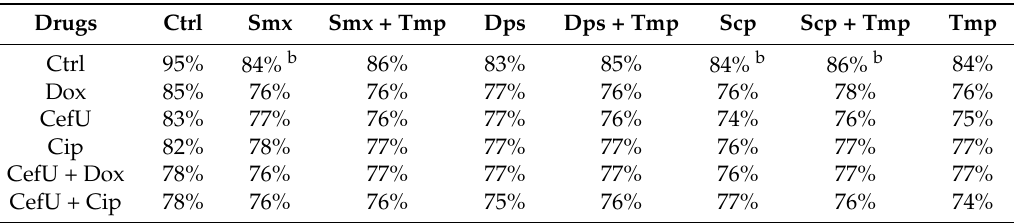
Table 1. Relative activity of drugs at blood drug combinations on a seven-day-old B. burgdorferi stationary phase culture a